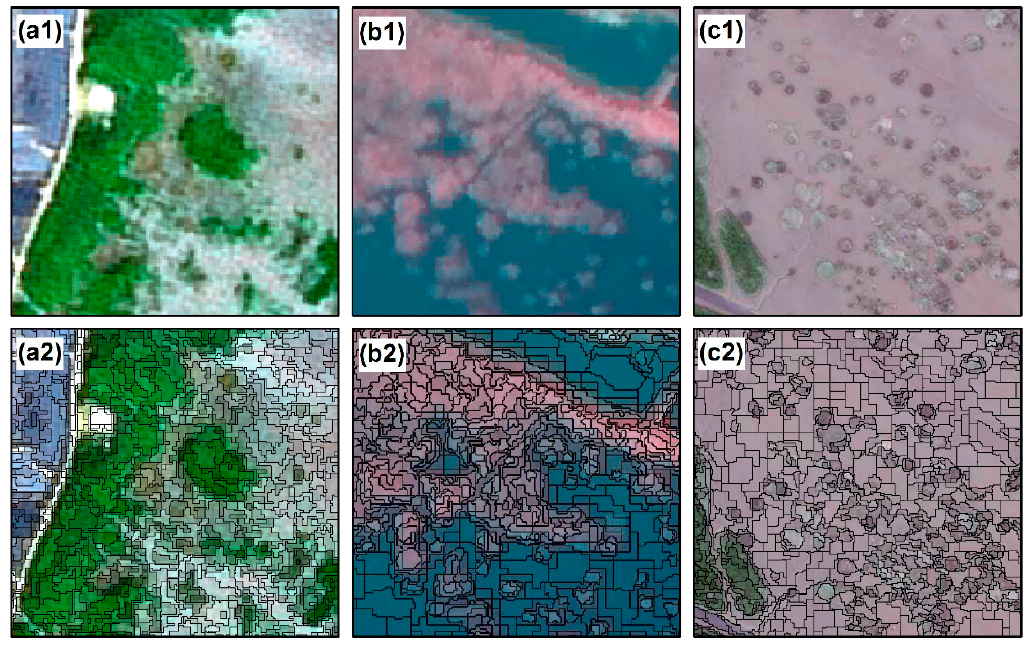
Figure 2. Segmentation results of multi-source high-resolution images: ( a1 )–( c1 ) illustrate images of three typical regions of different data sources; ( a2 )–( c2 ) show segmentation results of the three parts corresponding to ( a1 )–( c1 ).